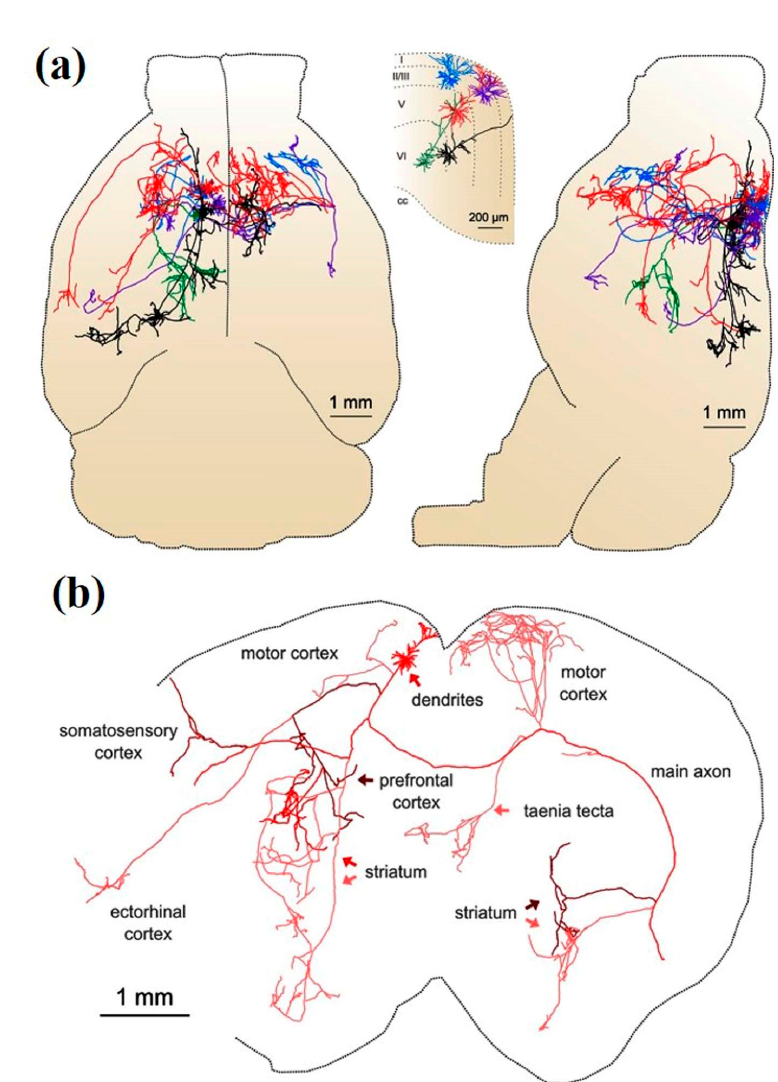
Figure 2. Complete reconstruction of axonal morphology. ( a ) Complete reconstruction of the five projection neurons, superimposed on a horizontal (left) and sagittal (right) position while imaging the mouse brain. The subset comprises pyramidal neurons in layer II (blue, purple), layer V (red, black), and layer VI (green). ( b ) Axonal and dendritic reconstruction of the layer, five pyramidal cells (colored red in ( a ) presented in the coronal plane. The black dashed line depicts the profile of the coronal section at the rostrocaudal position of the cell body. Colored segments highlight axonal arbors initiating from common branch points. Reprinted with the permission of the authors of [63].